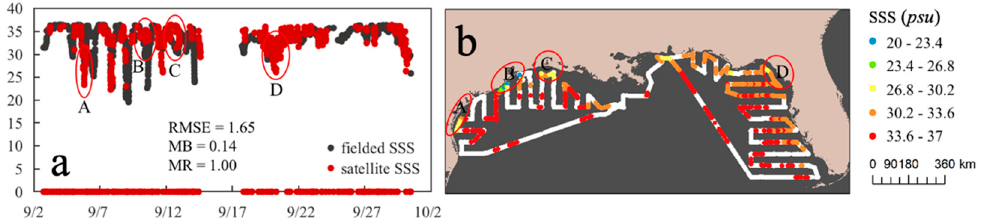
Figure 10. Performance of the SSS model in quantifying SSS in the northern GOM, cruise data dis- tributed in the coastal area and open sea. ( a ) Comparison between field-measured SSS and MODIS-derived modeled SSS, the red dots on the X -axis indicate that there are no corresponding MODIS-derived SSS; ( b ) spatial distributions of the MODIS-derived SSS along the cruise track in ( a ), colored by field-measured value, white color indicates no MODIS data. Table 7. Model comparison in independent validation of cruise GU1609Leg1-3 Fall Pelagic Trawl/Acoustic Survey, the overall result of each cruise was listed with blue background.